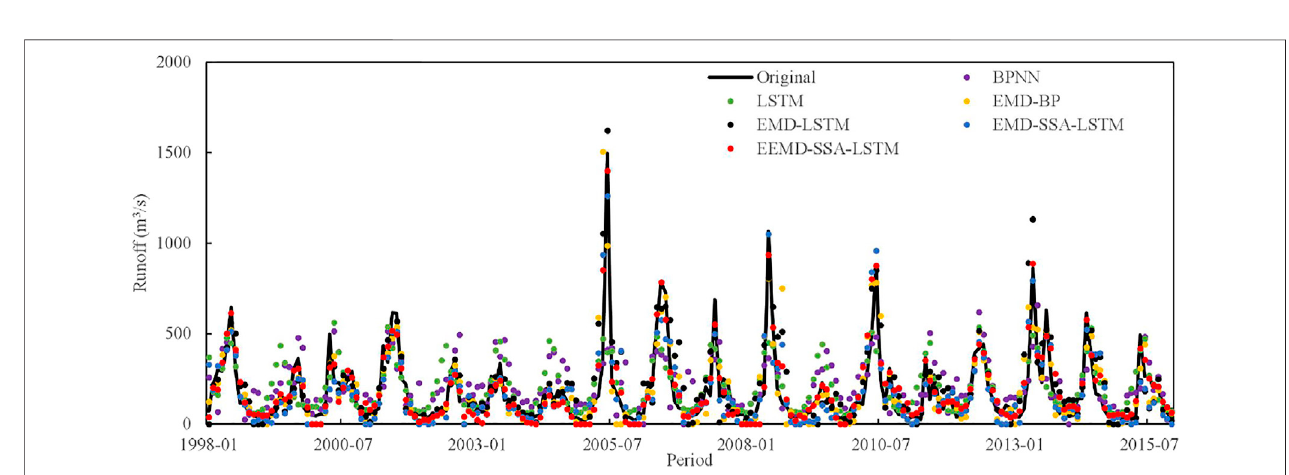
FIGURE 5 | Comparison of the forecast results for the Xinfengjiang Reservoir during the validation period.